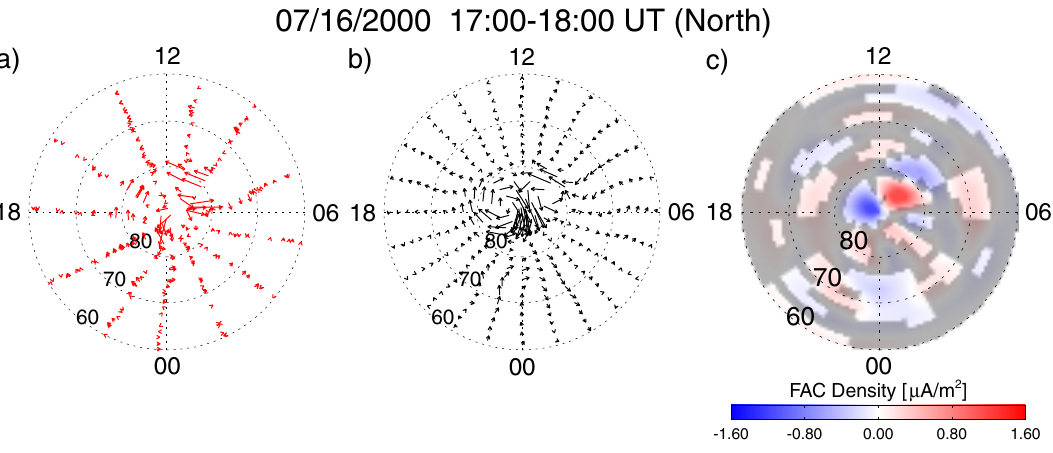
Fig. 2. Iridium observations and derived quantities for 16 July 2000, from 17:00–18:00 UT in AACGM MLT-MLAT coordinates: ( a ) Iridium samples of the magnetic field perturbations, ( b ) their spherical harmonic fit, and ( c ) the derived distribution of field-aligned currents. Upward (downward) Birkeland current are shown in red (blue). Birkeland currents below the quiet-time baseline are masked in